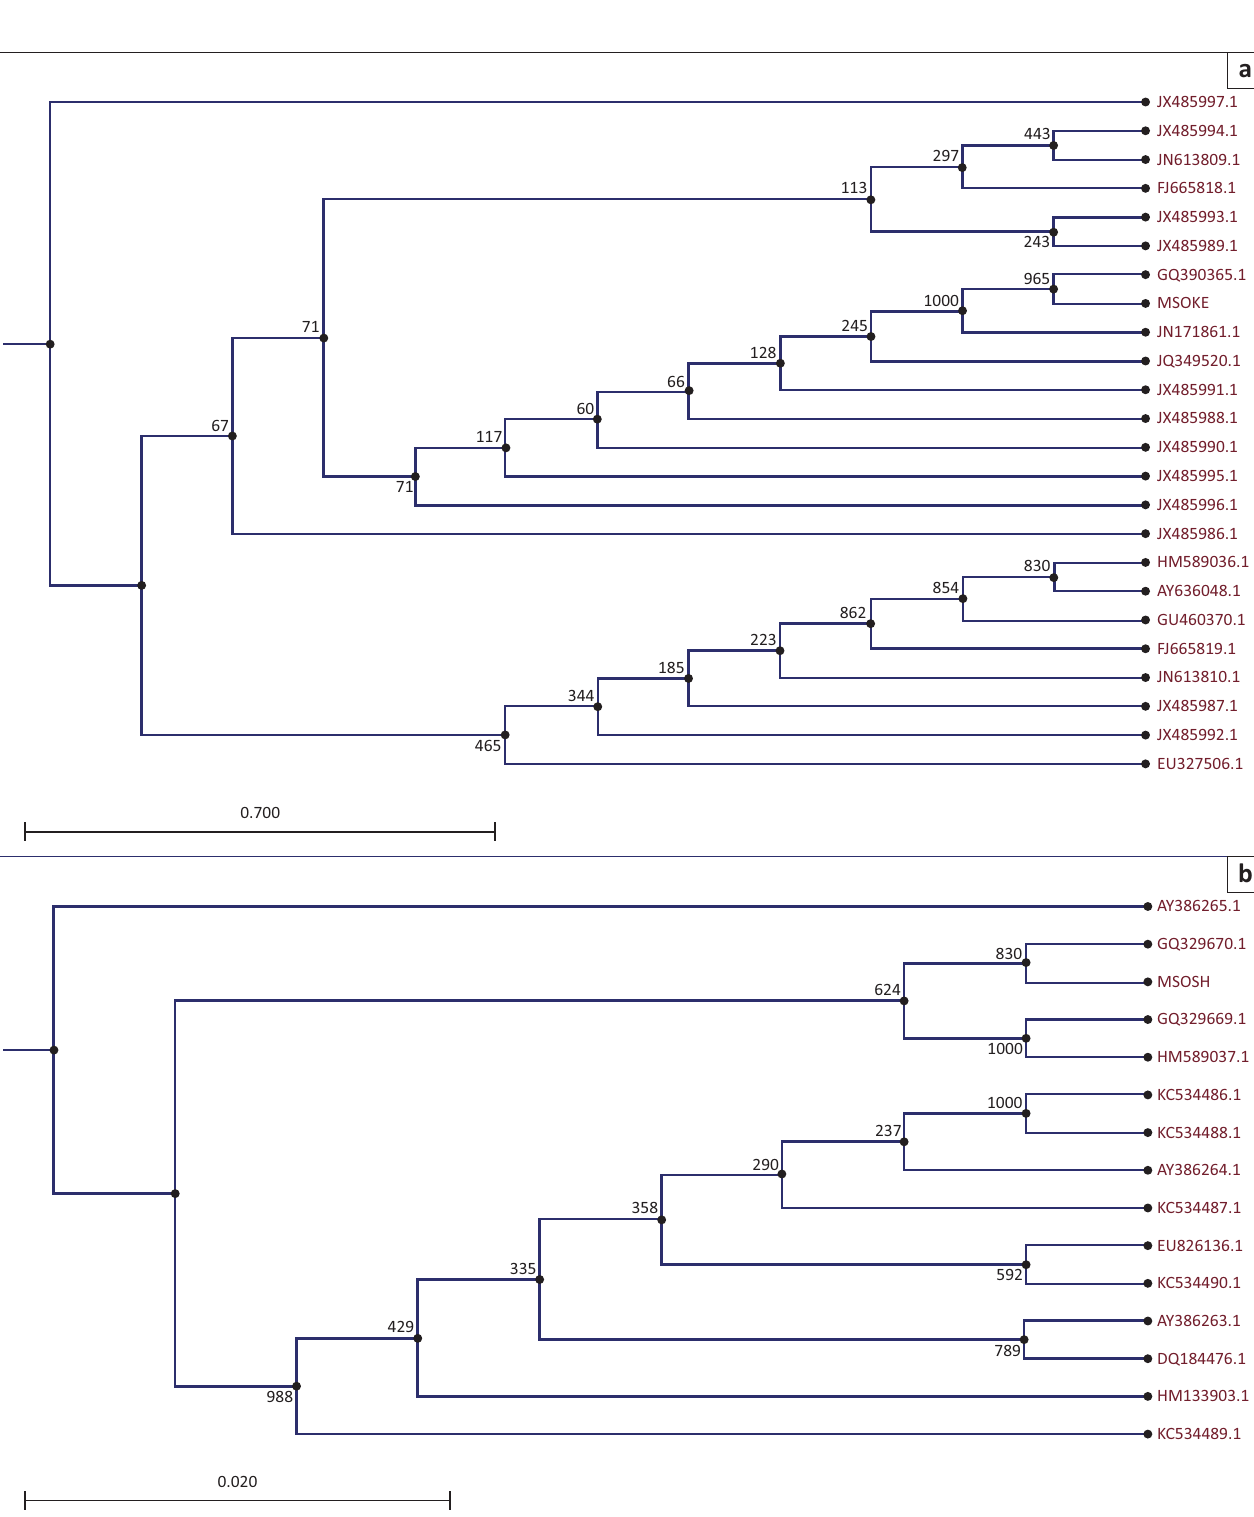
The numbers at each branch represent bootstrap values. The bar represents the genetic distance. FIGURE 1: Phylogenetic analysis of the Orf virus based on the (a) ORF011 and the (b) ORF045 gene. The phylogenetic trees were constructed using the neighbour-joining algorithm in CLC Main workbench 5.5 with 1000 bootstrap